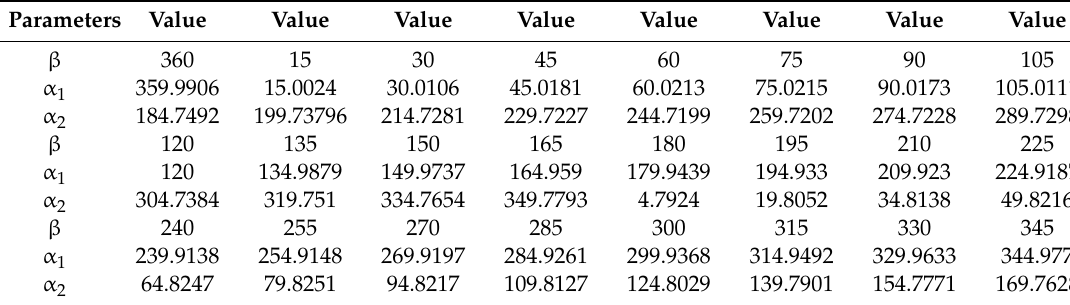
Table 1. Results of the circular grating angle measurement error ( ° ).